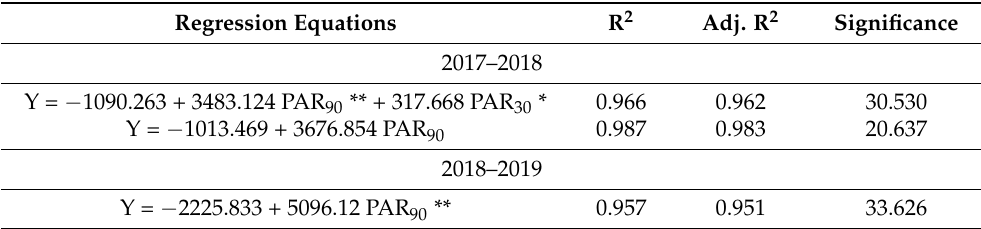
Table 7. Effect of intercepted PAR on seed yield of grass pea. Regression Equations R 2 Adj. R